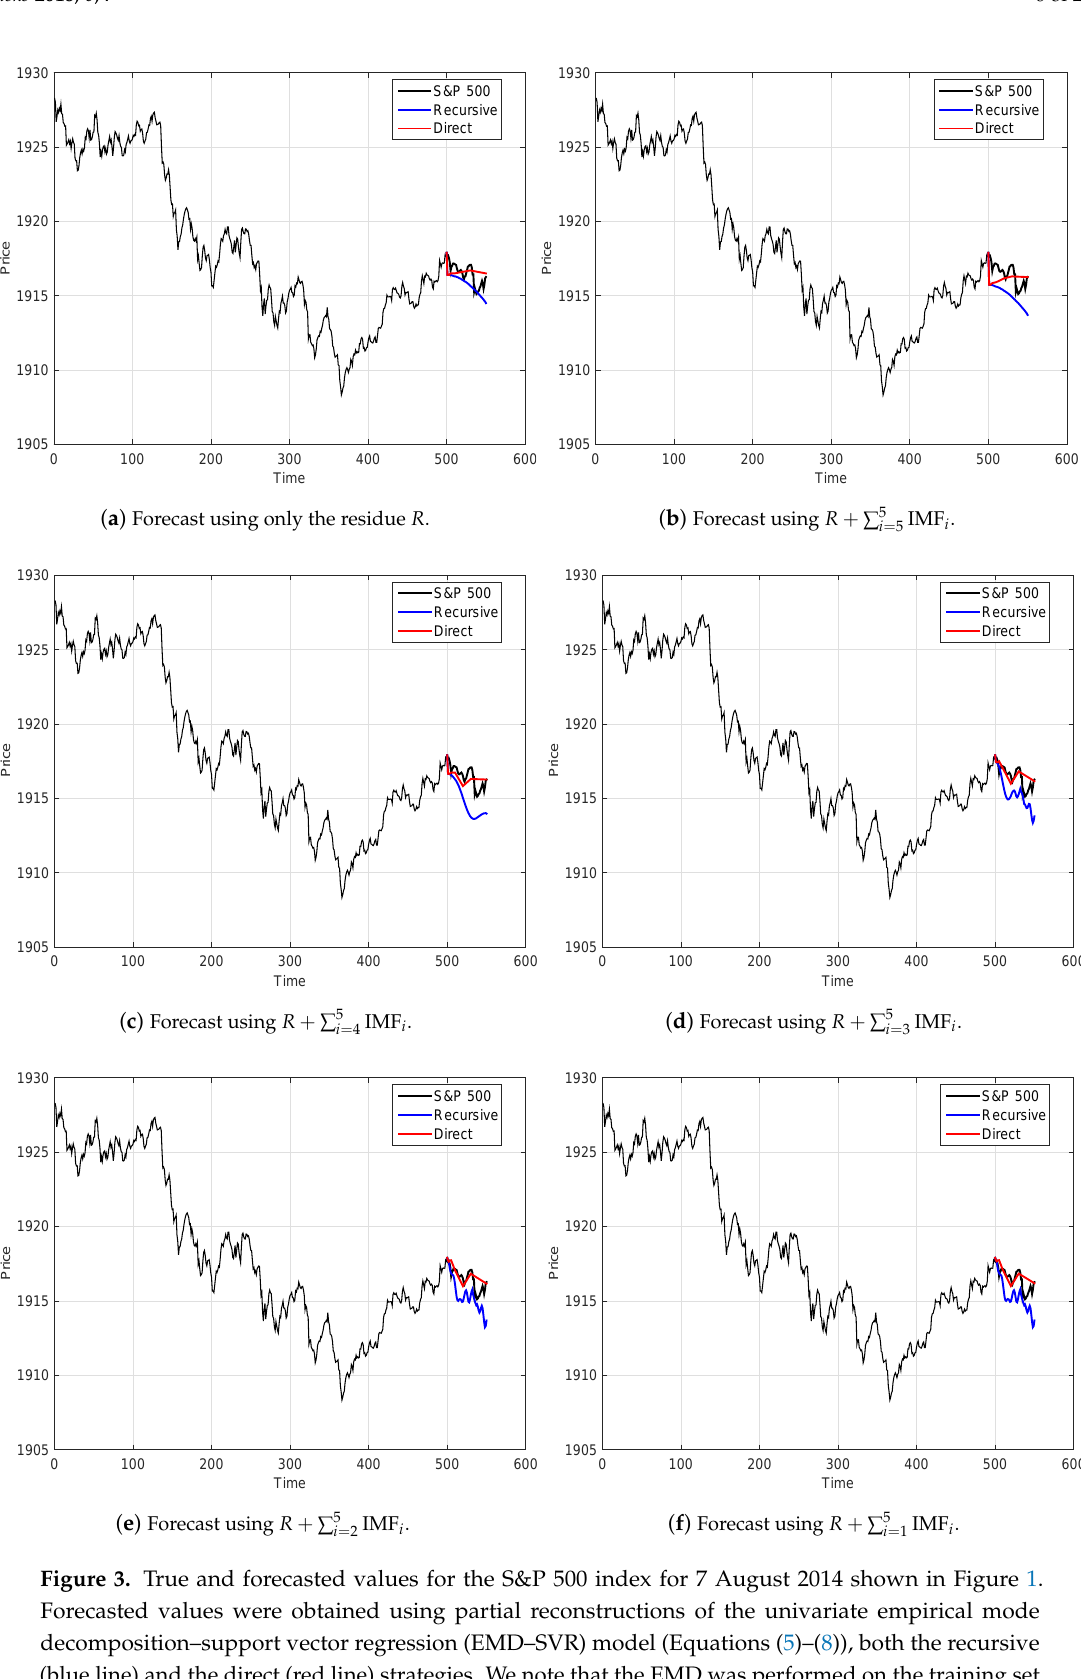
Figure 3. True and forecasted values for the S&P 500 index for 7 August 2014 shown in Figure 1. Forecasted values were obtained using partial reconstructions of the univariate empirical mode decomposition–support vector regression (EMD–SVR) model (Equations (5)–(8)), both the recursive (blue line) and the direct (red line) strategies. We note that the EMD was performed on the training set only (i.e., using only data before beginning of